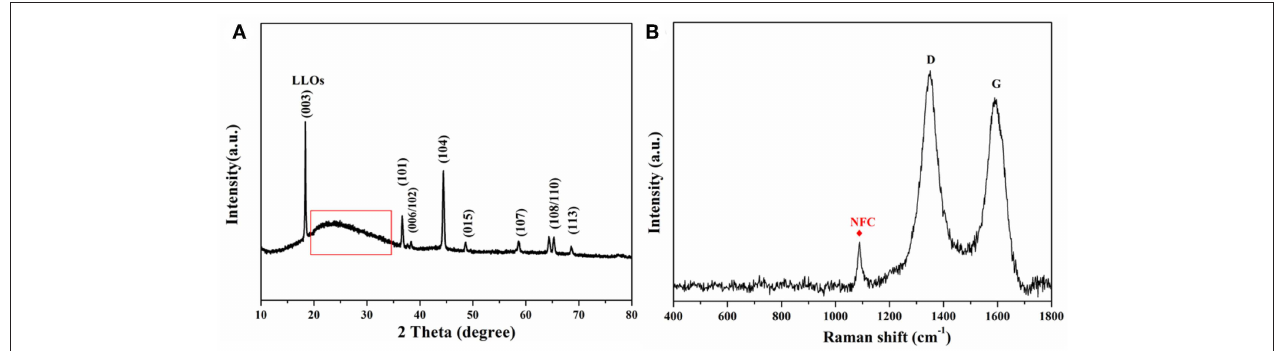
FIGURE 2 | (A) XRD patterns and (B) FSRS of the LLOs/CNTs/NFCs.